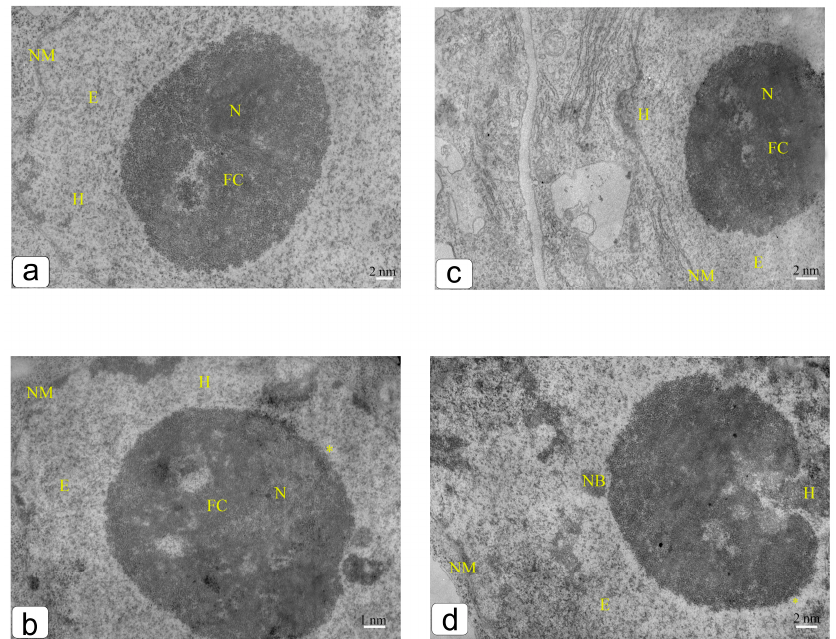
Figure 7. Photographs of nuclear ultrastructural organization in the cells of the primary root cortex of the YaLF line ( a )control, ( c ) 150 mM NaCl) and cv Recordsmen ( b ) control, ( d ) 150 mM NaCl)